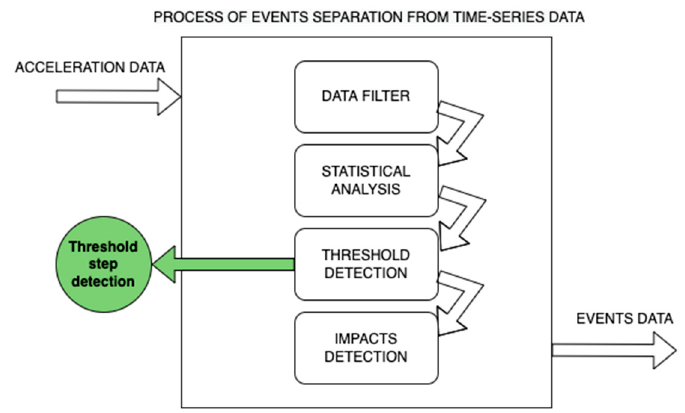
Figure 2. Flowchart of the proposed solution for event detection.